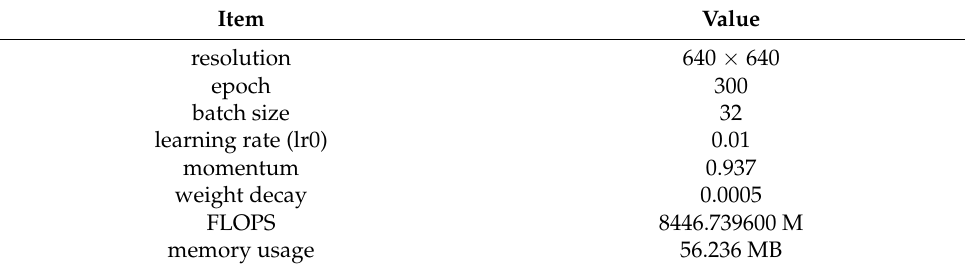
Table 6. The parameters used in YOLOv5s training.